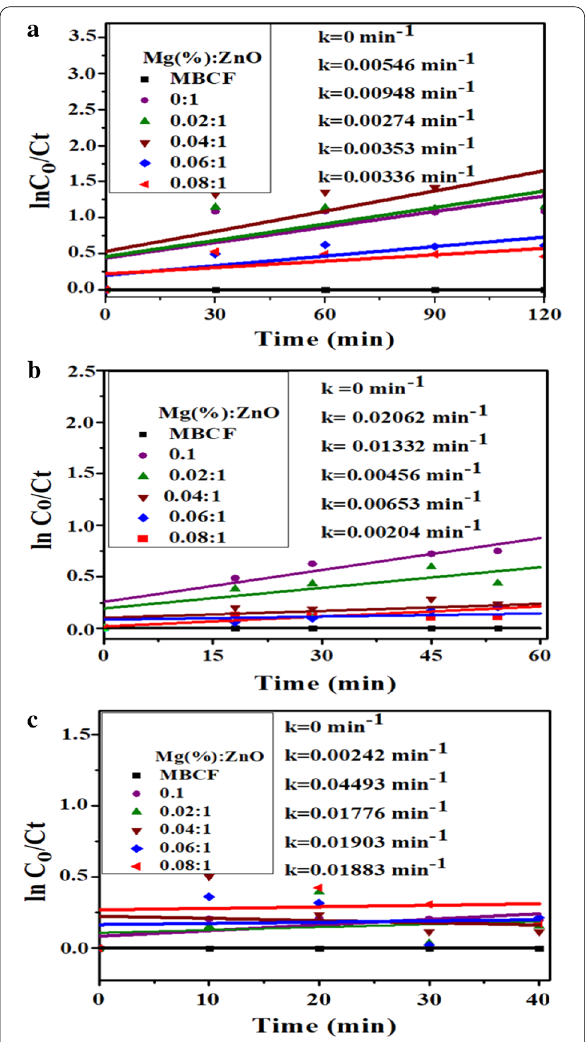
Fig. 7 a Photocatalysis, b sonocatalysis and c sonophotocatalysis reaction kinetics of MBCF dye degradation for Mg‑doped ZnO